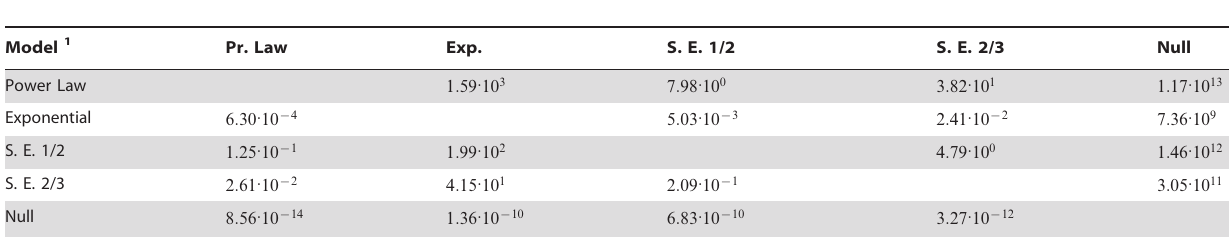
Table 1. Likelihood Ratios of L -Maximized